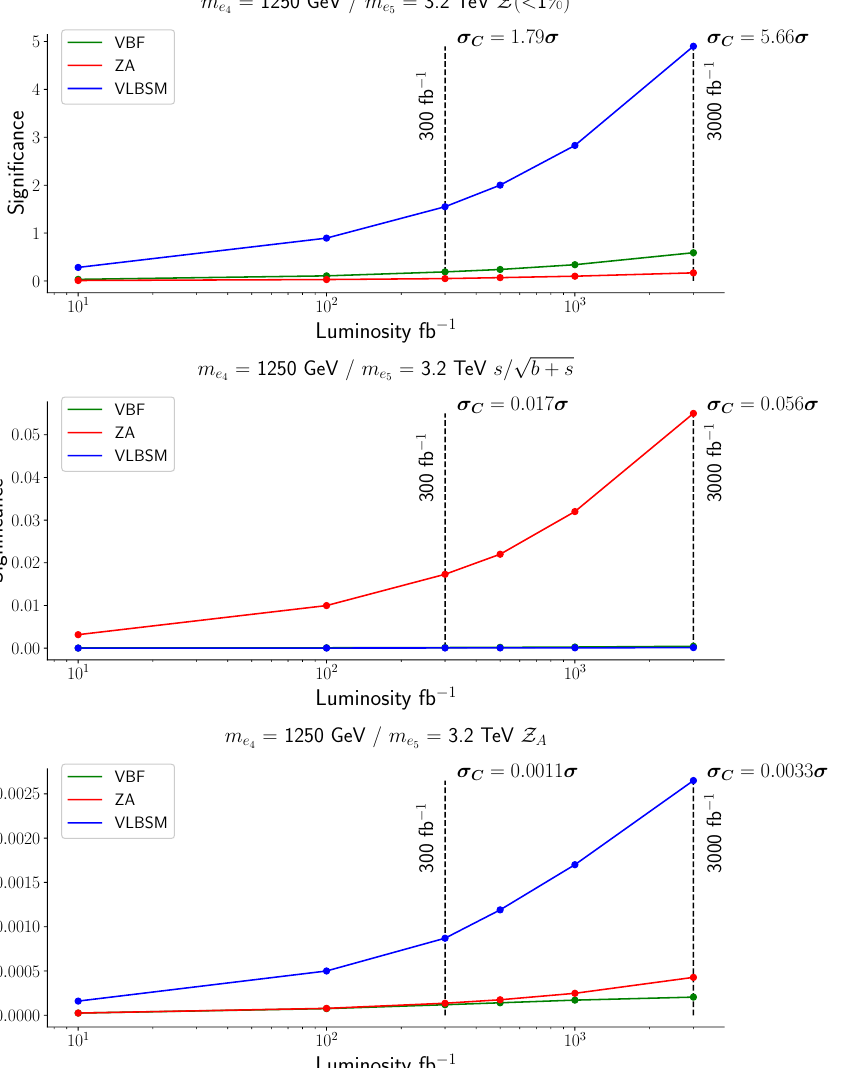
Figure 16. The same as in figure 15 but for a lightest VLL mass m = 1250